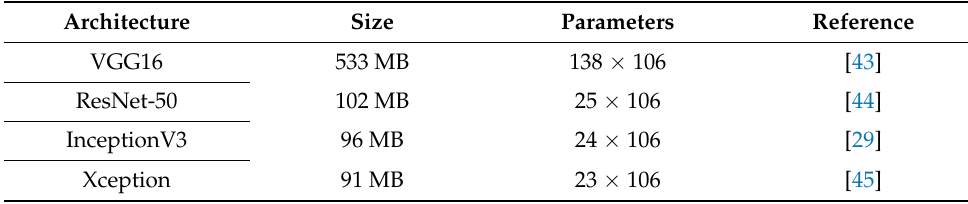
Table 1. Architectures selected for